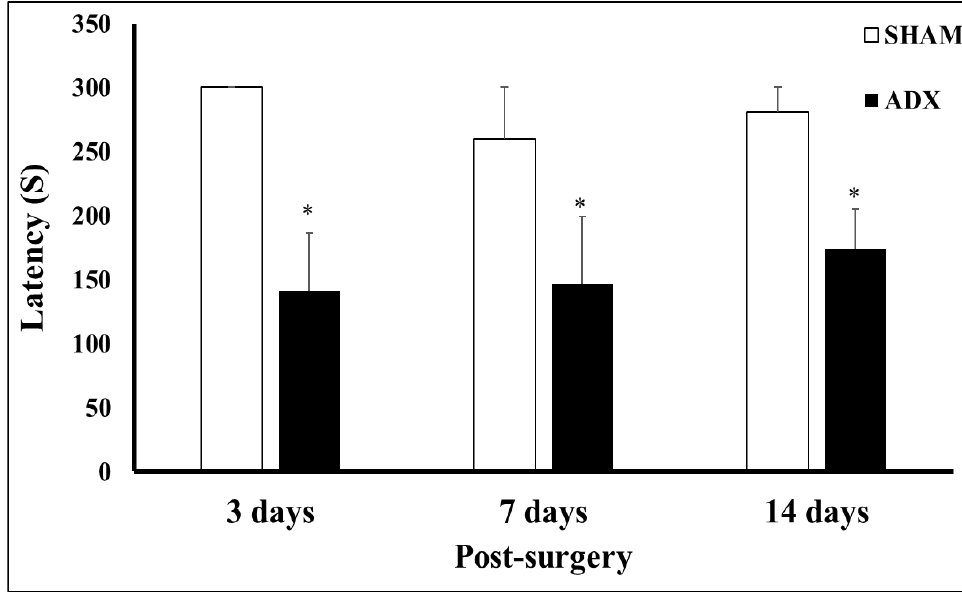
Figure 9. Bar graphs showing latency time on the retention day of ADX and SHAM operated rats following 3, 7, and 14 days following bilateral adrenalectomy. * p < 0.05. 3 days (SHAM = 6, ADX = 9), 7 days (SHAM = 8, ADX = 10), and 14 days (SHAM = 7, ADX = 16).